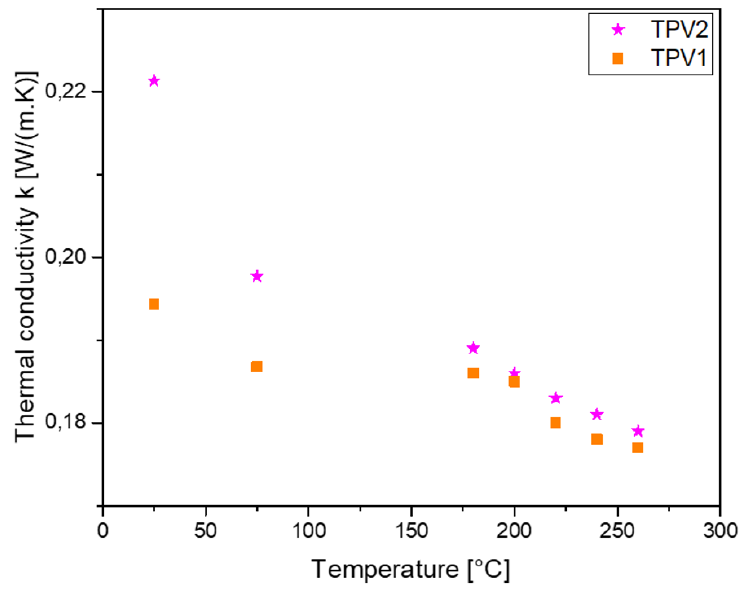
Figure 24. Thermal conductivity versus temperature for TPV1 and TPV2. Table 7. Thermal conductivity of TPVs under